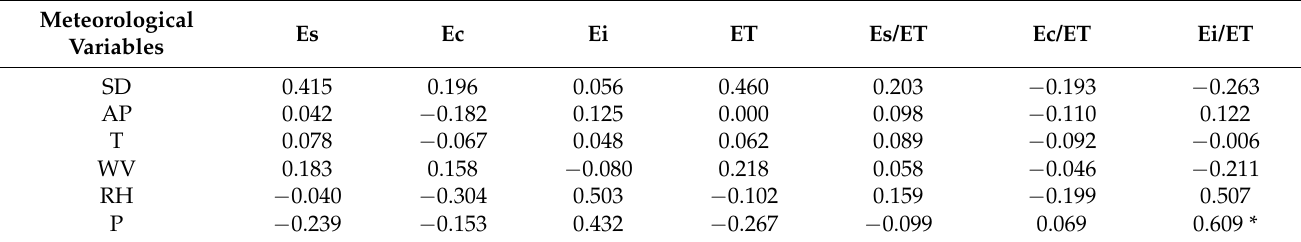
Table 3. Correlation coefficients between the interannual variations in ET components and meteorological variables.